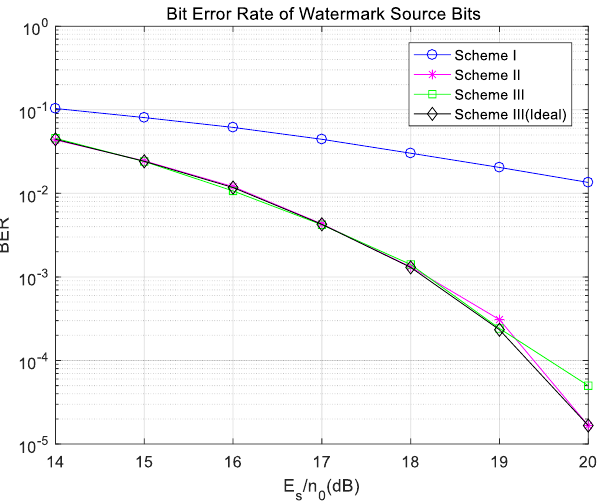
Figure 14. Bit error rate of the watermark bits with a frequency offset in the Gaussian channel.